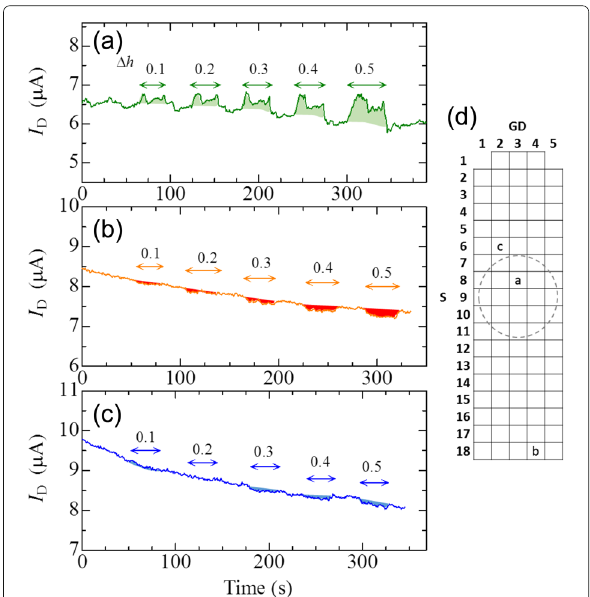
Fig. 5 Time response of the drain current to a slight touch with an object. The variation of the drain current in an OTFT in the fingertip-shaped OTFT array was detected in relation to a vertical displacement of (cid:2) h under V GS = − 30 V and V DS = − 30 V . The observed drain current in the OTFT increased during the application of the displacement, and the drain current difference during the compressionclearlydependson (cid:2) h . d LocationmapoftheOTFTarray and contact area with micrometer rod. The dotted circle indicates the direct contact area of the OTFT array with the micrometer rod. The (S8, GD3) pixel is directly under the rod, the (S18, GD4) pixel is far from the contact area, and the (S6, GD3) pixel is near the contact area